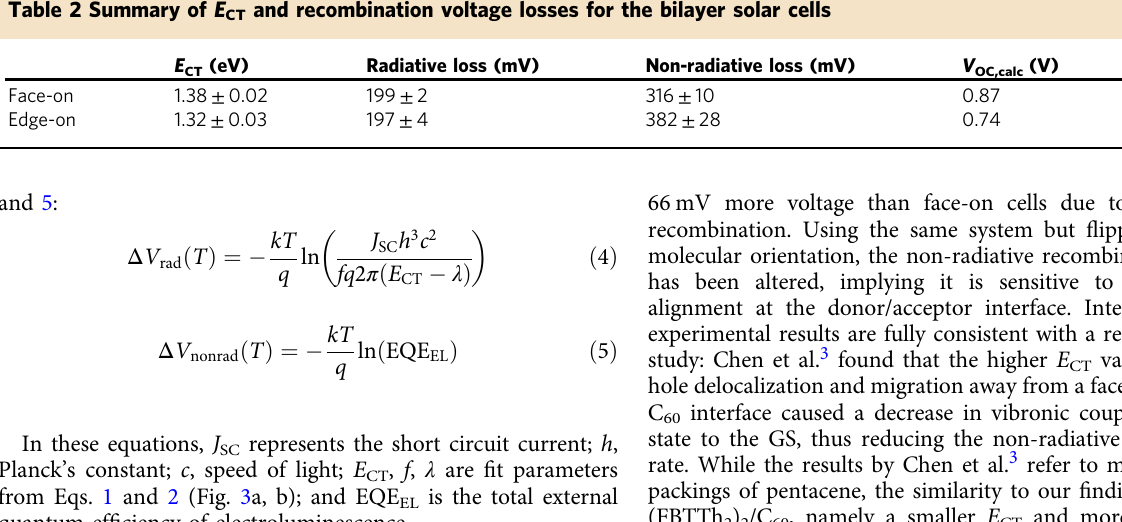
Table 2 Summary of E CT and recombination voltage losses for the bilayer solar